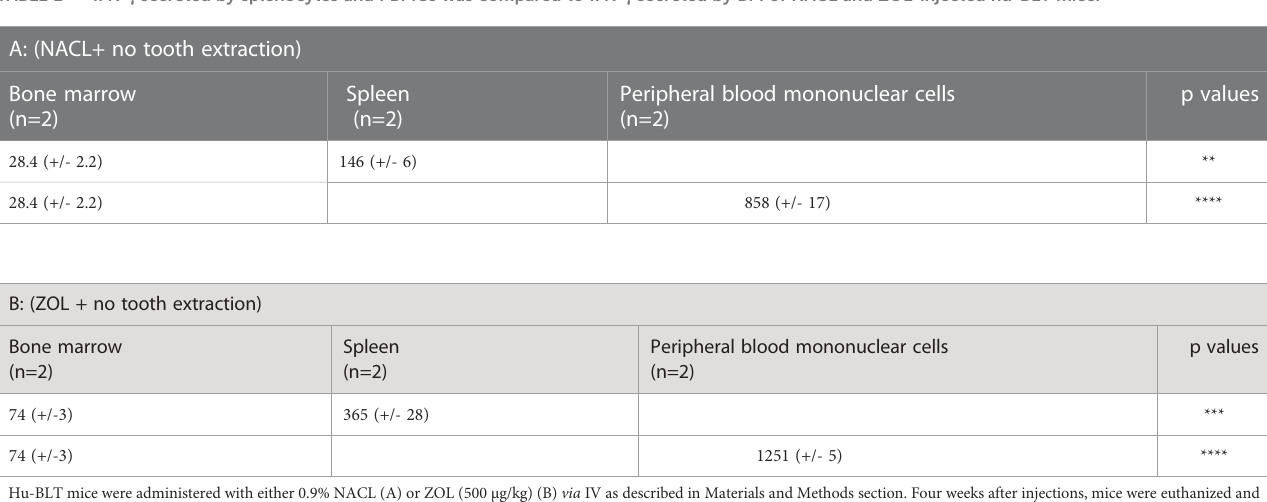
TABLE 1 = IFN- g secreted by splenocytes and PBMCs was compared to IFN- g secreted by BM of NACL and ZOL-injected hu-BLT